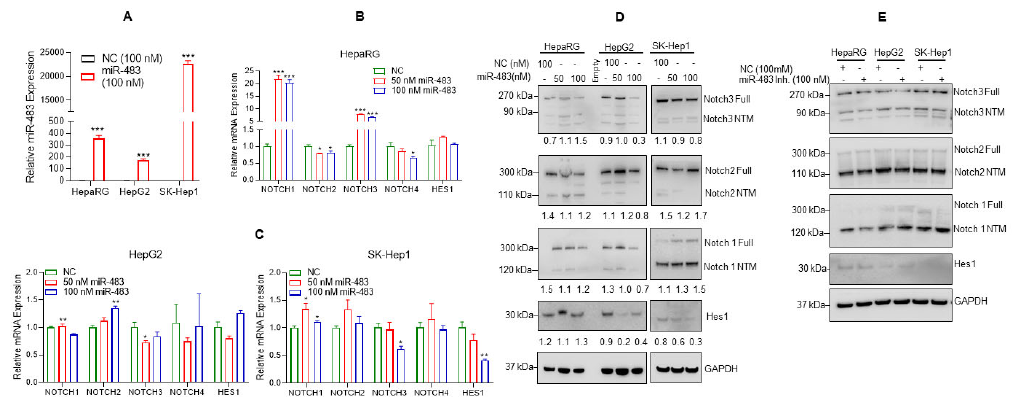
Figure 2. miR-483 affects Notch signaling. ( A ) HepaRG, HepG2, and SK-Hep1 cells were transfected with NC (negative control) mimic or miR-483 mimic for 24 h, and the expression of miR-483 was analyzed by RT/qPCR. *** p < 0.001 compared to NC-transfected cells. ( B , C ) Expression of Notch 1 , Notch 2 , Notch 3 , Notch 4, and HES 1 mRNA levels after transfection of HepaRG, HepG2, and SK-Hep1 cells with NC and miR-483 mimic was analyzed by RT/qPCR. * p < 0.05, ** p < 0.01, *** p < 0.001 compared to NC transfected cells. ( D ) HepaRG, HepG2, and SK-Hep1 were transfected with NC and miR-483 mimics for 24 h, and cell lysates were immunoblotted with anti-Notch 3, anti-Notch 2, anti-Notch 1, Hes1, and GAPDH antibodies. The band intensities were quantified using ImageJ software (https://imagej.nih.gov/ij/, accessed on 12 February 2023) and presented. ( E ) HepaRG, HepG2, and SK-Hep1 were transfected with NC, or miR-483 inhibitor (Inh.) for 24 h, and cell lysates were immunoblotted with anti-Notch 3, anti-Notch 2, anti-Notch 1, Hes1, and GAPDH antibodies. The uncropped blots are shown in Supplementary